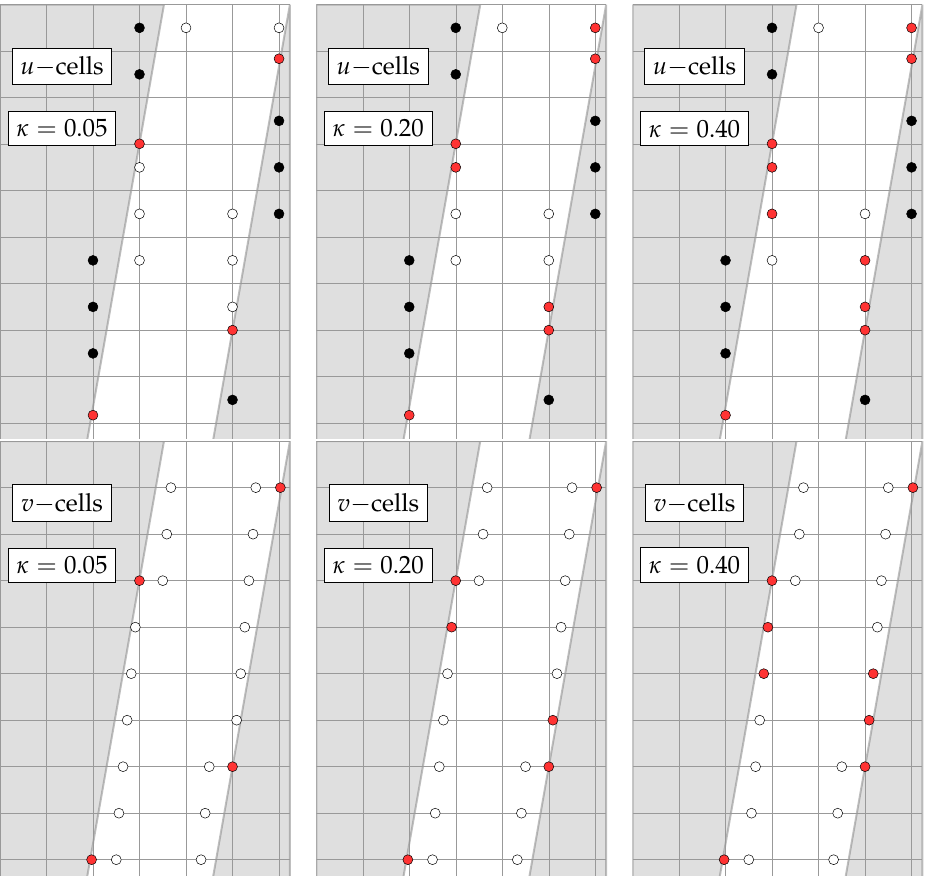
Figure 19. Fluid (white), solid (black) and slave (red) cells distribution around the immersed solids for the inclined channel flow case with the 22 × 22 grid and ψ =